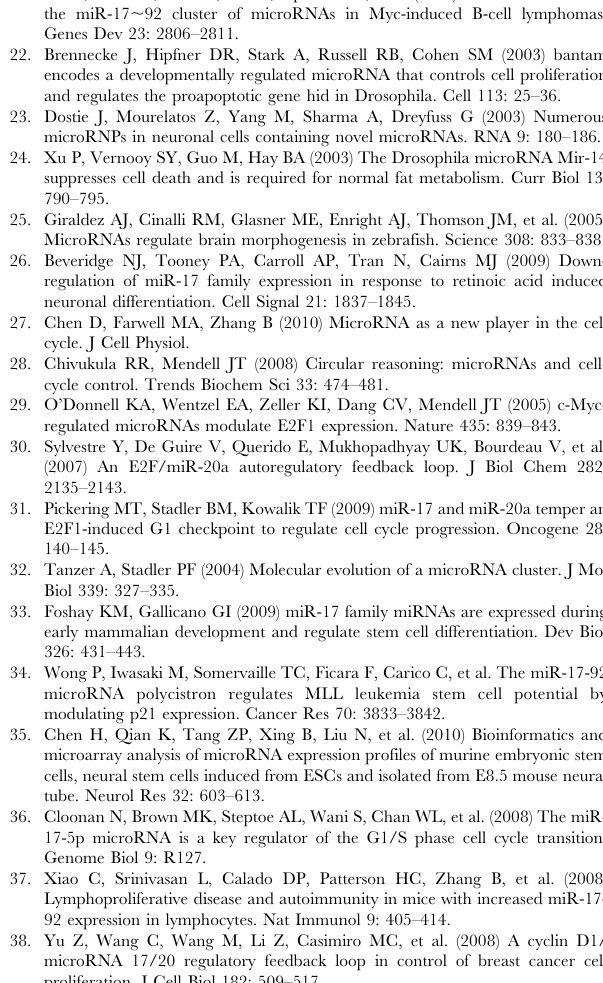
Figure S3 List of cell-cycle related genes predicted as targets for miR-17, miR-20a, and miR-106b. Total predictions from the DIANA prediction tool (http://www.diana. CELL CYCLE and PROLIF by using the DAVD database